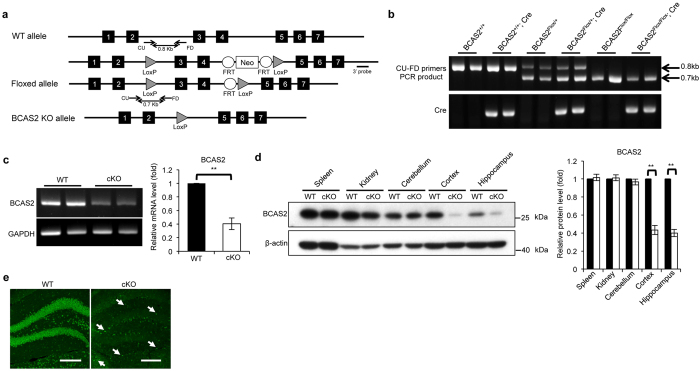
Generation of BCAS2 conditional knockout (cKO) mice.(a) Schematic representation of the BCAS2 gene targeting strategy. The LoxP-floxed allele contains one LoxP inserted between exons 2 and 3 and the other LoxP inserted between exons 4 and 5 with two Flip recombinase targets (FRTs) flanking the Neo cassette. The Neo cassette was removed by Flip recombinase. Exons 3 and 4 were deleted by CaMKIIα-iCre recombinase. CU and FD are primers for genotyping. (b) Genotyping by PCR. BCAS2Flox/+;CaMKIIα-iCre+ offspring were crossed with each other, which resulted in 6 different genotypes. Genomic DNA was extracted from tails of offspring. Upper: The sizes of the bands identified by CU and FD primers were 0.8 kb for BCAS2+/+, 0.8 and 0.7 kb for the heterozygous BCAS2-floxed allele (BCAS2Flox/+), and 0.7 kb for the homozygous BCAS2-floxed allele (BCAS2Flox/Flox). Lower: Cre gene. In this study, BCAS2Flox/Flox;CaMKIIα-iCre+ mice were considered the forebrain-specific BCAS2 cKO mice and were named cKO; the WT mice were BCAS2+/+ and contained the Cre gene. (c) RT-PCR analysis of the BCAS2 mRNA expression in WT and BCAS2 cKO mice at 12 weeks of age. Left, representative RNA. Right, quantification of the left panel (n = 3). (d) Western blot analysis of the BCAS2 protein levels for each genotype at 12 weeks of age. Left, representative western blot. Right, quantification of the left panel (n = 3). (e) Immunofluorescence assay (IFA) showing the BCAS2 expression level in 12-week-old WT and cKO mice. White arrow: BCAS2 expression in astrocytes of cKO mice. Scale bar: 200 μm. Uncropped blots are presented in Supplementary Fig. S5.